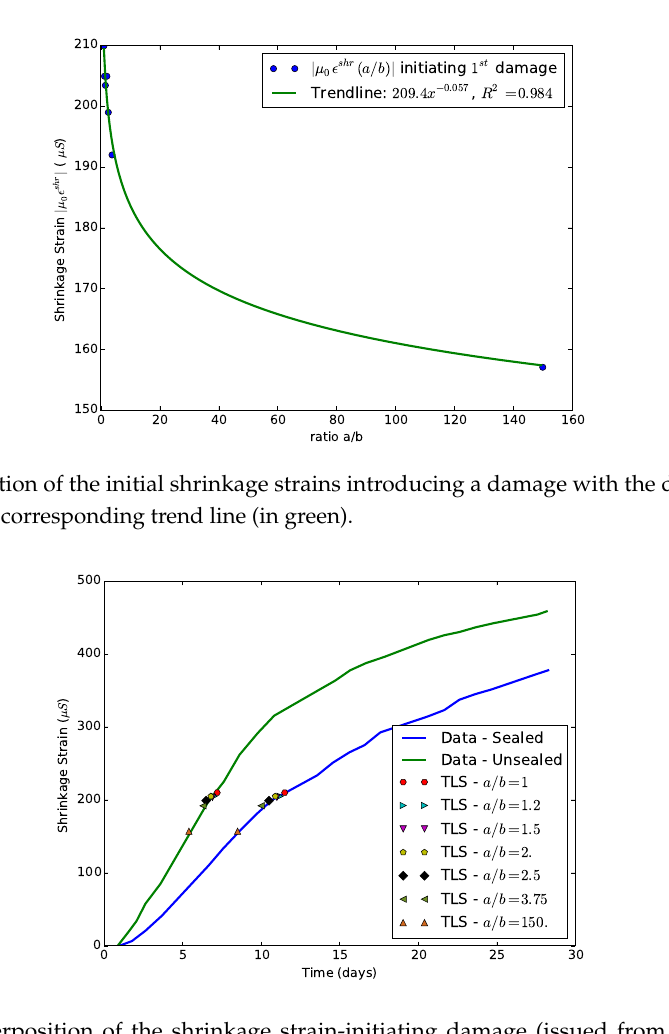
Figure 11. Superposition of the shrinkage strain-initiating damage (issued from the TLS) to the experimental free shrinkage measurements